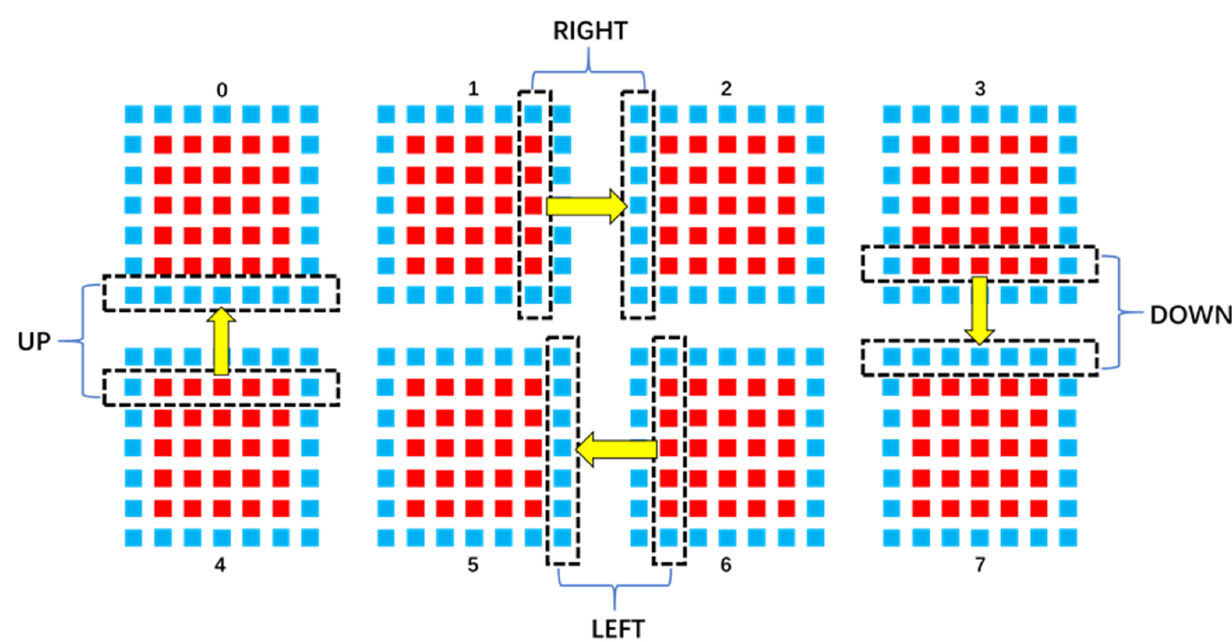
Figure 4. The communication of the decomposed domain. (In each communication step, the outer- most red real lattices are communicated into the adjacent outermost virtual lattice, as shown by the yellow arrow).